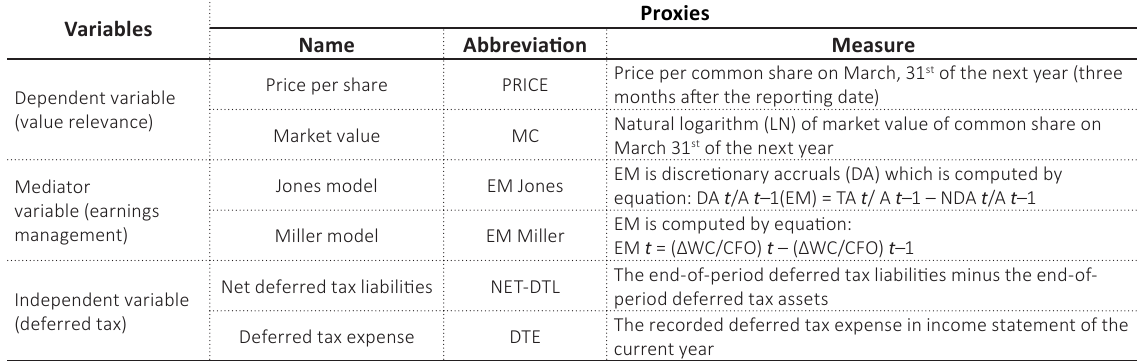
Table 1. Variable measurement